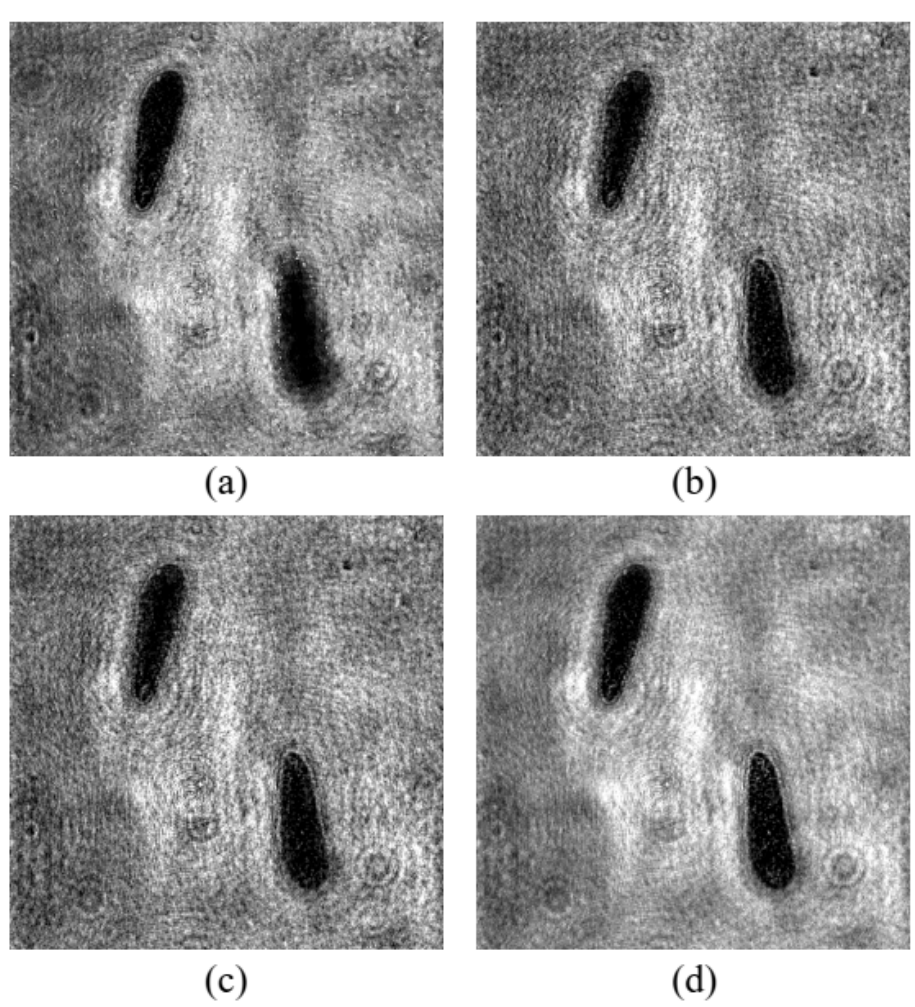
Figure 6. The results of different image fusion methods. ( a ) Result of PCNN, ( b ) result of RW, ( c ) result of PW, and ( d ) result of DHM-FCN.